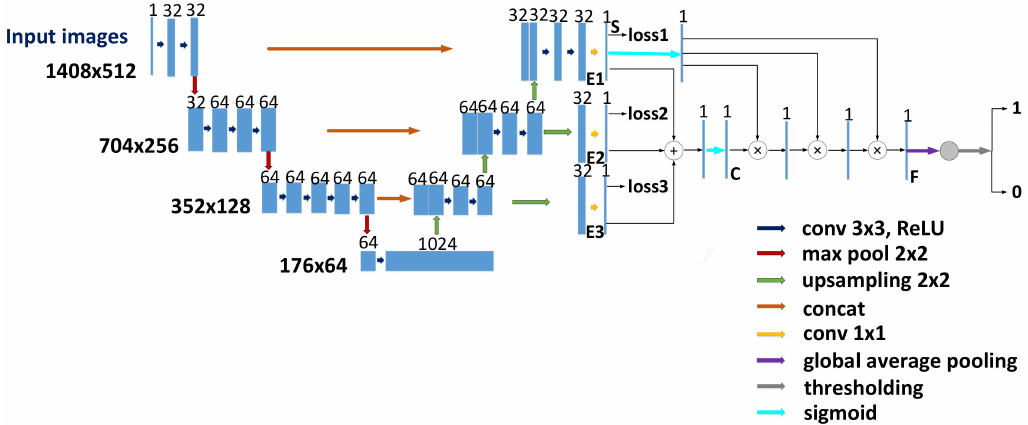
Figure 1. Proposed one-stage model for surface defect